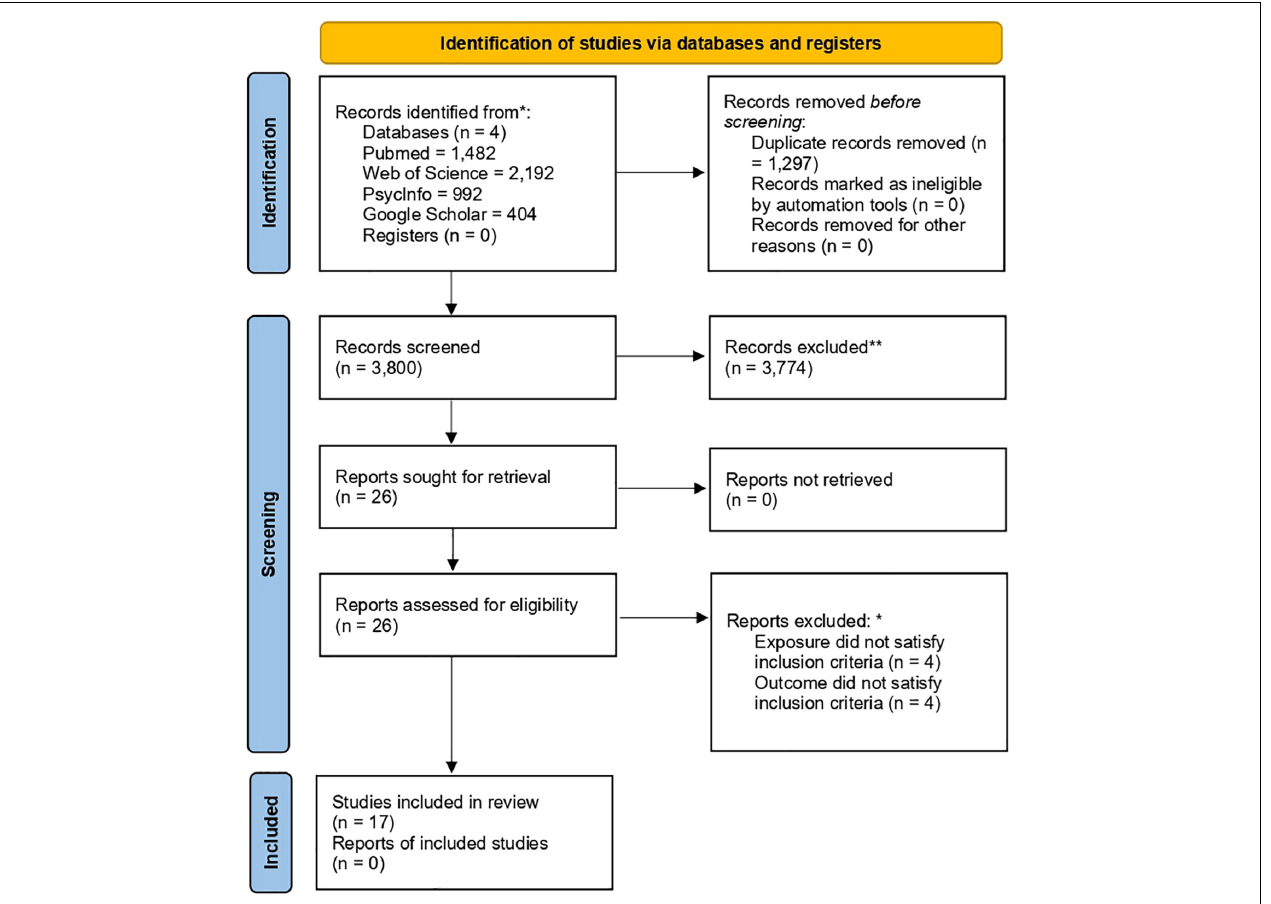
FIGURE 1 | Preferred Reporting Items for Systematic Reviews and Meta-Analyses (PRISMA) flow diagram. * , **More information on excluded articles is present in Supplementary Table 7